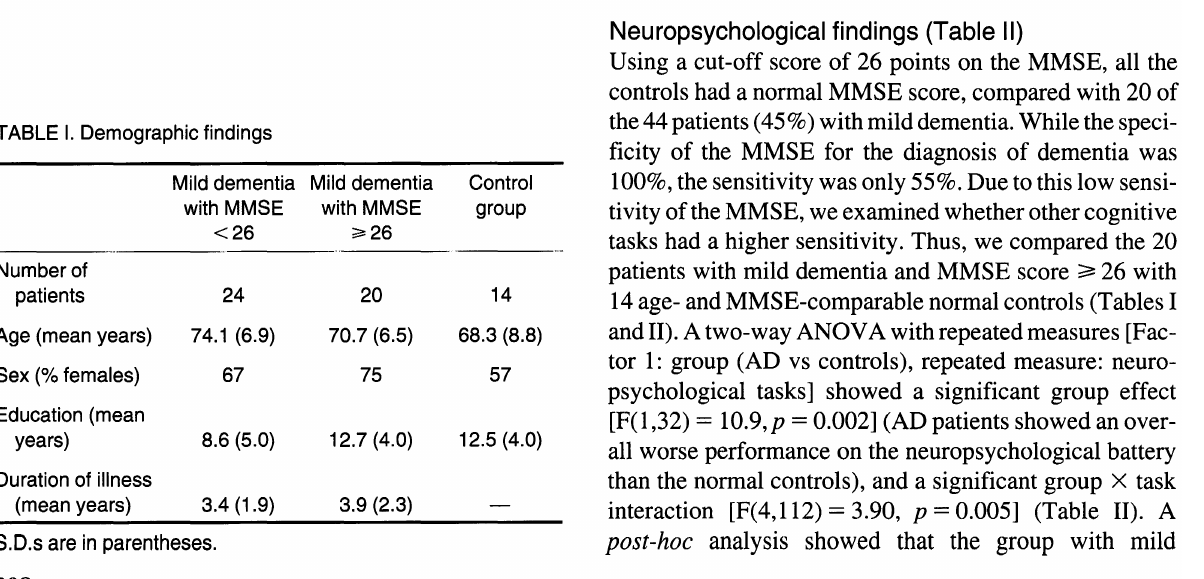
TABLE I. Demographic findings